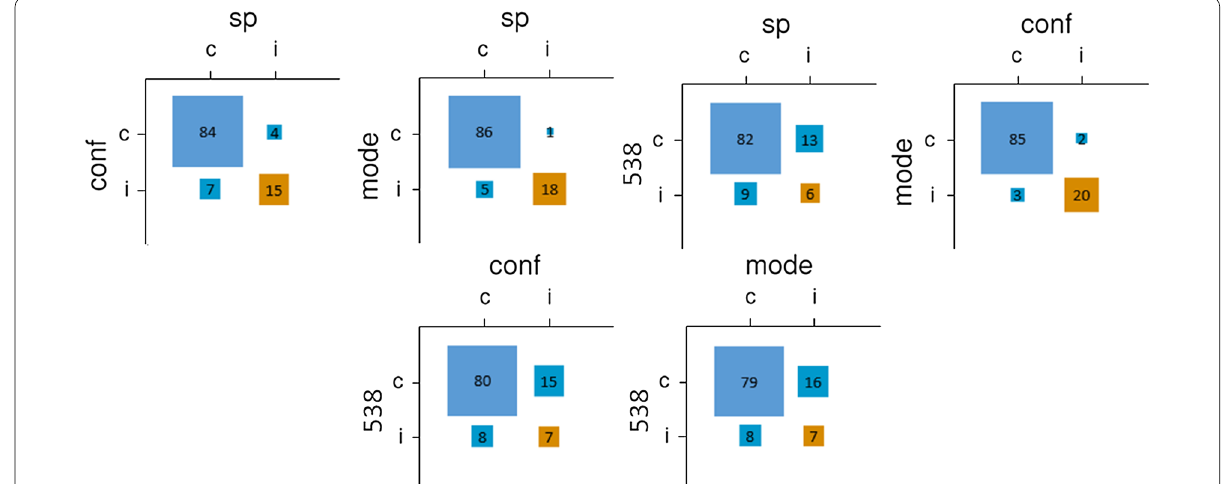
Fig. 5 Relationships between pairs of prediction methods for Study 2 (objectively assessed experts). Note sp conf confidence-weighted; mode =